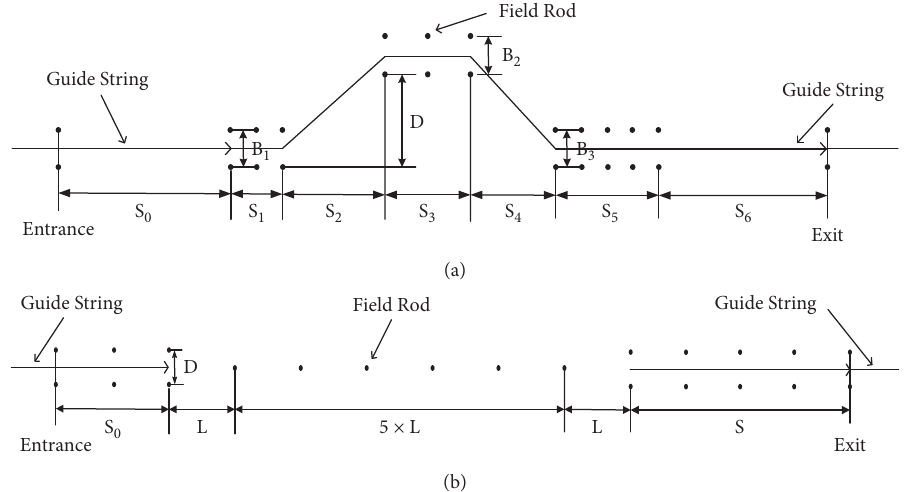
Figure 8: Standard test fields for stability simulation. (a) Standard test field for emergency double lane change ( S S 2 � 30m; S 3 � S 4 � 25 mm; S 5 � 30m; S 6 � 50m; D � 3.5m; B 1 � 1.1 b +0.25 � 2.12m; B 2 � 1.2 b +0.25 � 2.29m; B 3 � 1.3 b +0.25 � 2.46m. b refers to vehicle’s width, 1.7m). (b) Standard test field for pylon course slalom ( D � 2.48m; S 0 � 50m; S � 100 m; L �